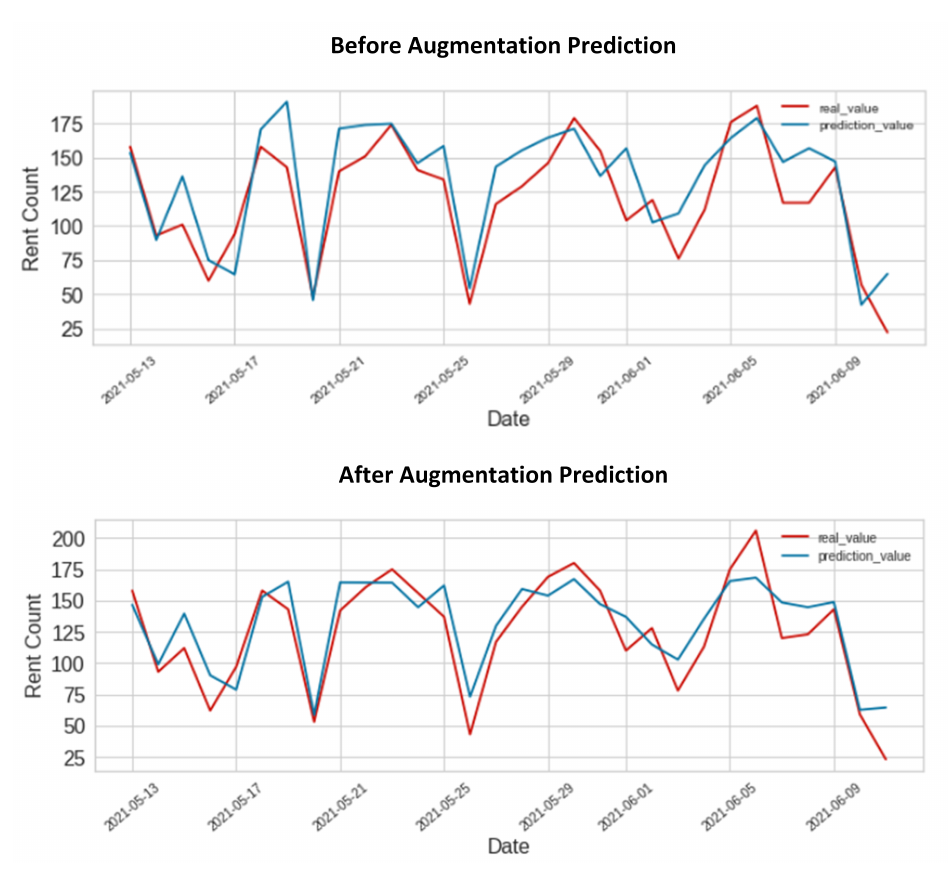
Figure 6. Plot of the proposed regression model prediction for test data compared with the original data and combined synthetic with original